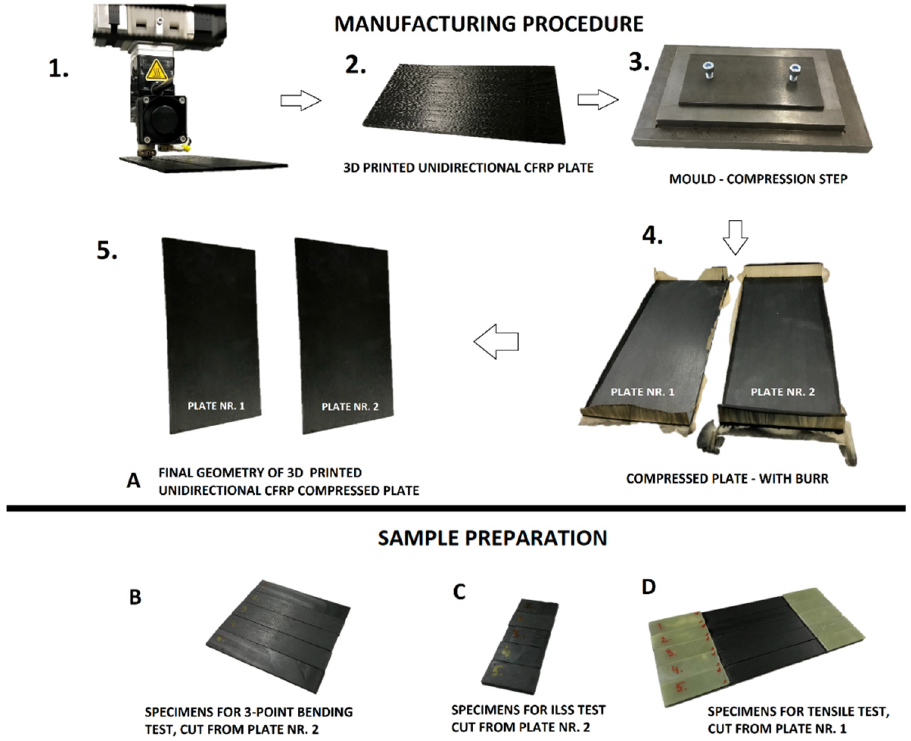
Figure 5. Manufacturing procedure (five steps) for material sample preparation. ( A ) is showing the final geometry of the 3D printed and compressed unidirectional CFRP plates. ( B ) depicts the cut specimens for the 3-point bending tests, ( C ) the specimens for the ILSS tests and ( D ) the tabbed specimens for the tensile tests in fibre direction.